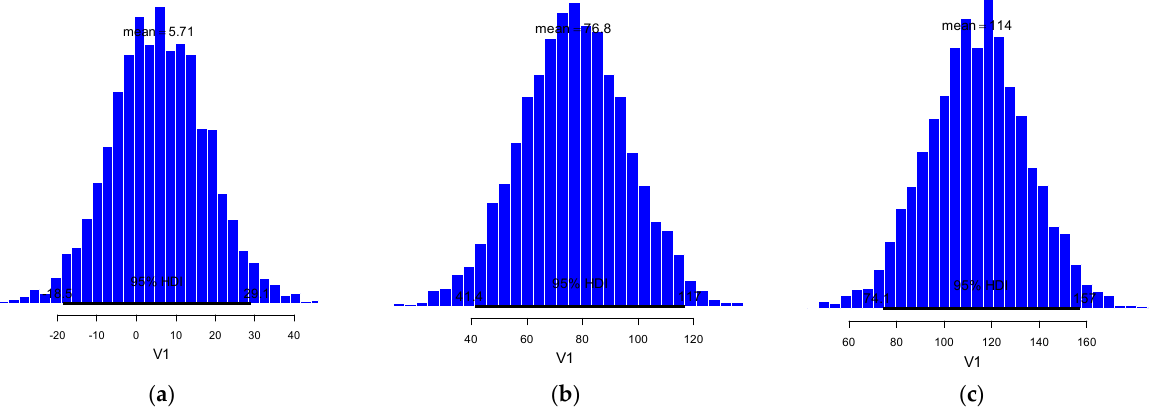
Figure 6. Posterior difference (V1) according to the Bayesian bootstrap procedure (n = 10,000) between predicted (2021) and observed degree-day risk thresholds (2022) expressed in terms of heat summations (i.e., peak in moth abundance) and the related 95% high density intervals (HDI), for the first ( a ), second ( b ) and third flight ( c ) of H. armigera . The posterior difference between the Bayesian degree—day thresholds developed